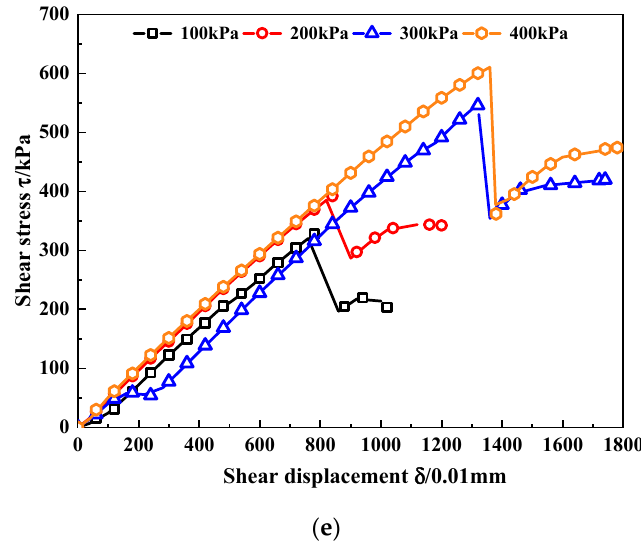
Figure 2. Shear displacement-stress curves of MCRA. ( a ) MCRA0. ( b ) MCRA0.5. ( c ) MCRA1.0. ( d ) MCRA1.5. ( e ) MCRA2.0.